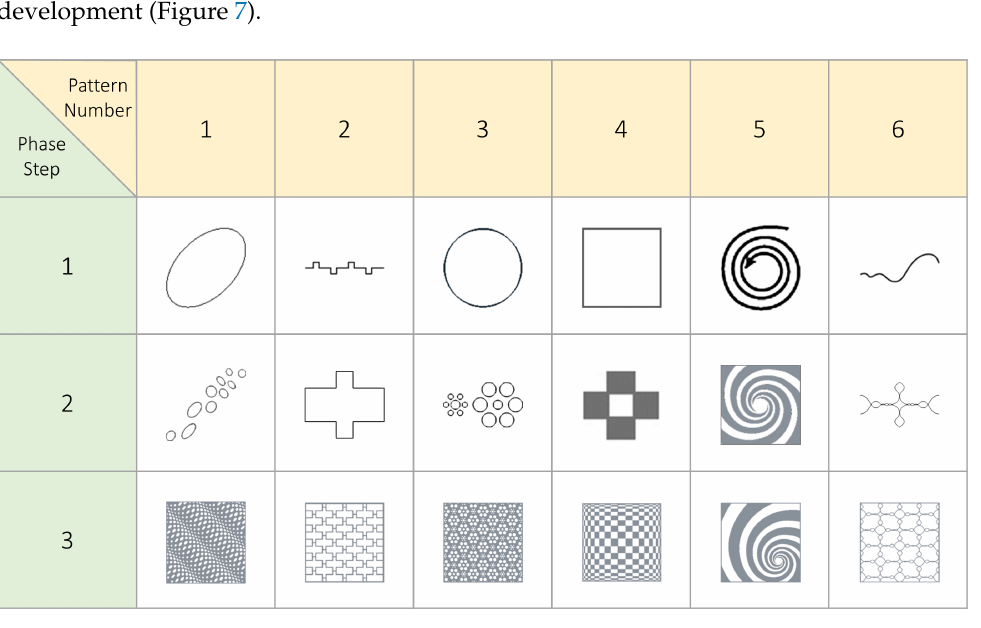
Figure 7. Development of